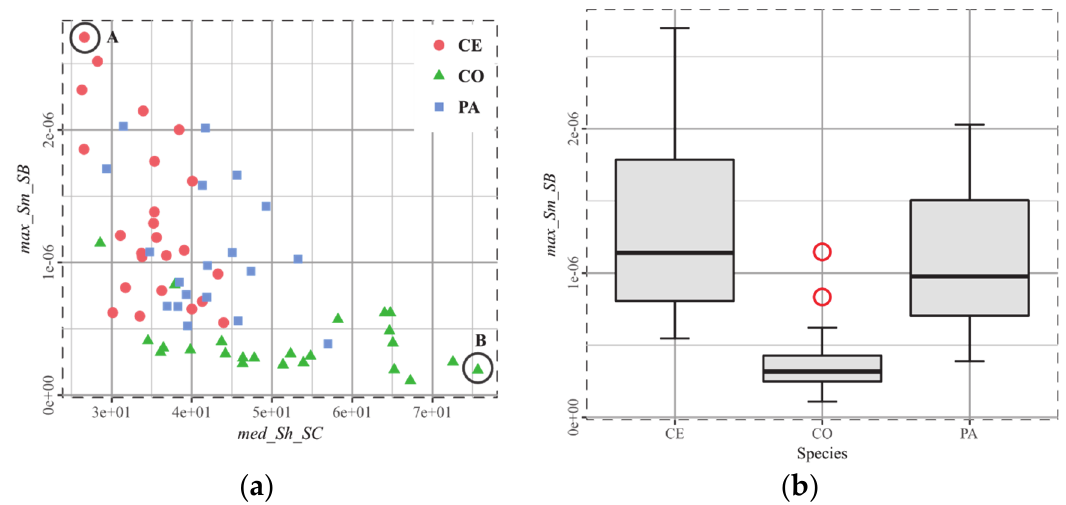
Figure 3. Old World Monkeys, most discriminating parameters. max_Sm_SB p -value for CE-CO: 6.95 × 10 − 13 , and for CO-PA: 1.05 × 10 − 9 ( a ) There is a clear boundary between Colobus (CO) and Cercocebus (CE). The surfaces related to the points (A) and (B) are represented in the ESM; ( b ) Box-whiskers representation of the best parameter (heteroscedasticity is clear, but it must be noted that the parameters are back-transformed for the graph presentation).